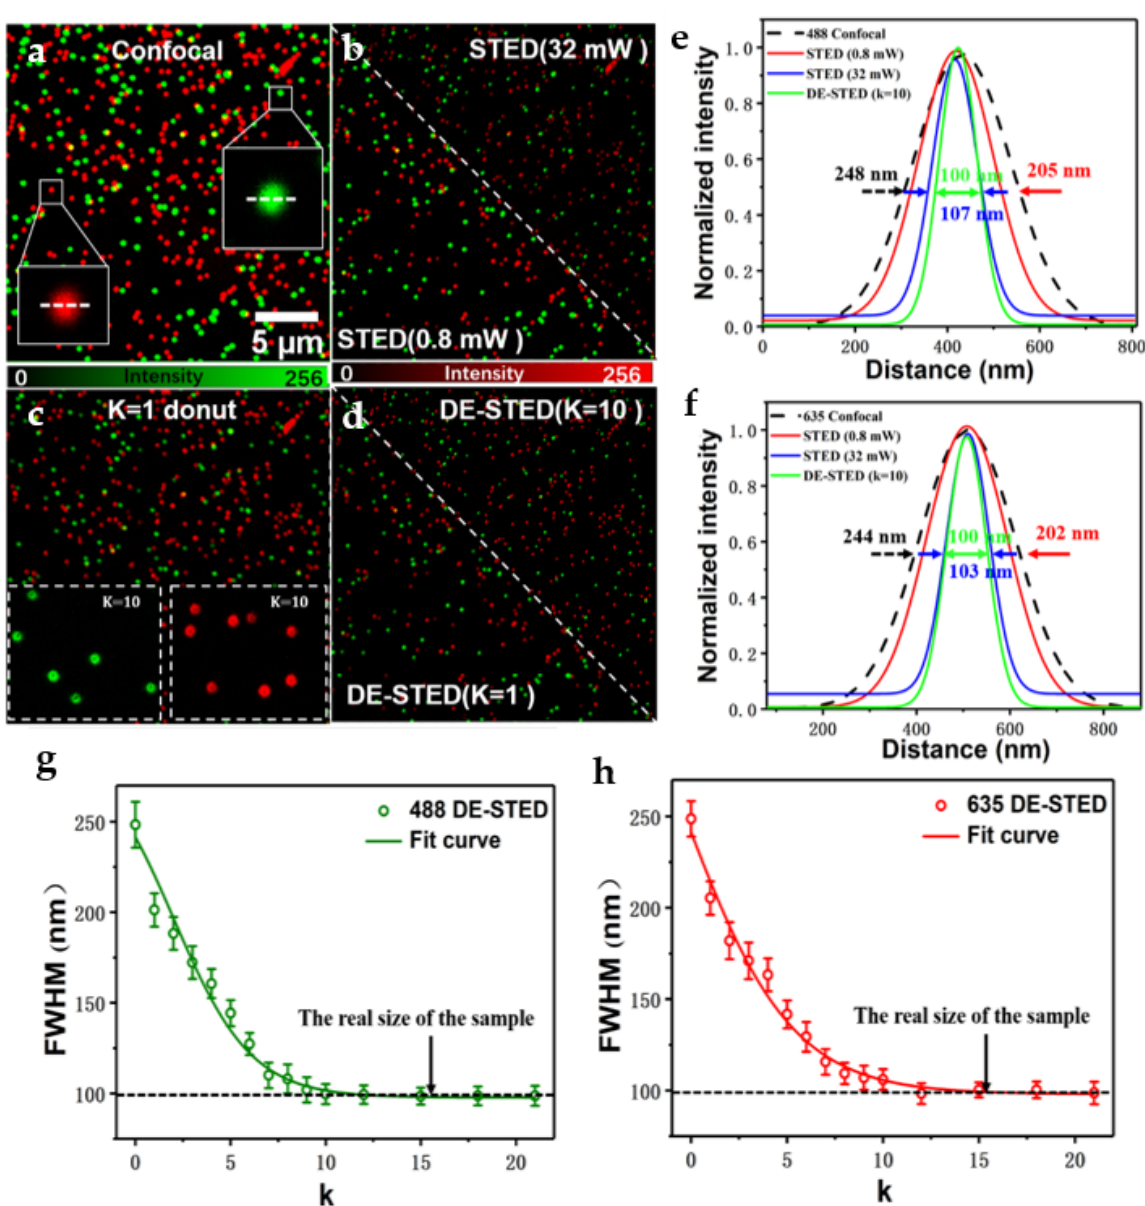
Figure 3. Imaging results of two-color DE-STED for fluorescent beads. ( a ) Two-color confocal image (green: 488 nm, red: 635 nm). ( b ) STED image with depletion power 0.8 and 32 mW. ( c ) Donut image, where the insets are donut images of k = 10. ( d ) DE-STED results at k = 1 and 10. ( e , f ) The resolution curves of the green and red channels for confocal, STED (0.8 and 32 mW), and k = 10 DE-STED, taking the marked fluorescent beads in ( a ) as the research object. ( g , h ) The curves of the relationship between FWHM and k value for the green and red channels. Scale bar: 5 μm.